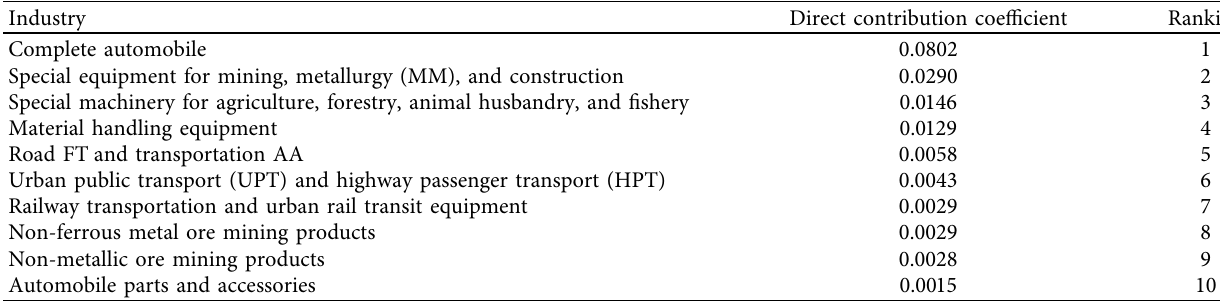
Table 4: Top 10 industries for direct contribution coefficient.